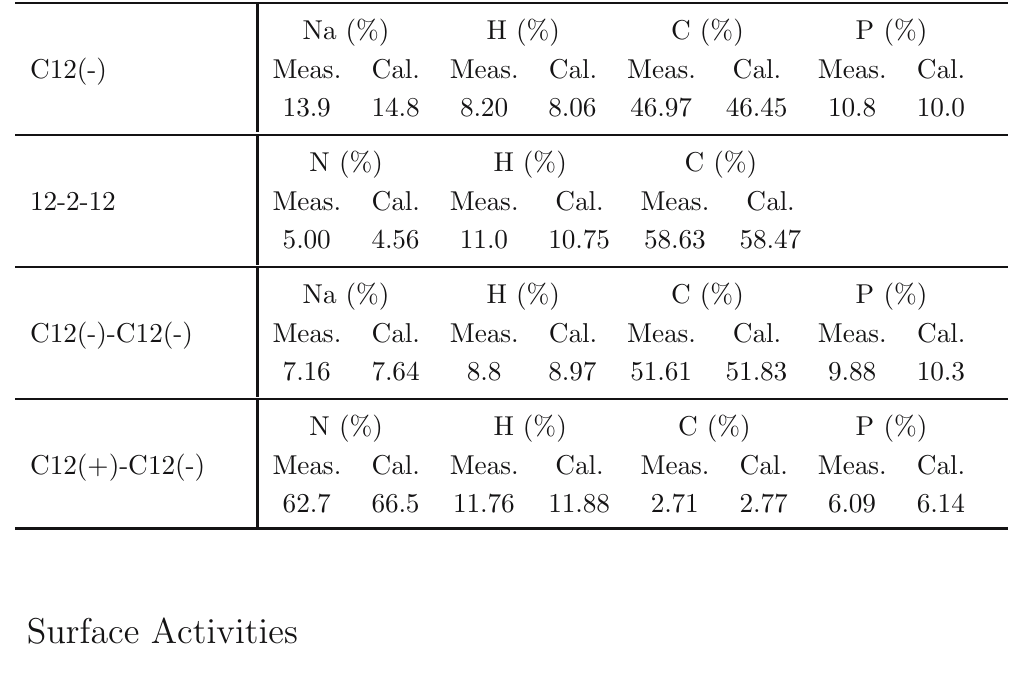
Table 2 Elemental Analysis Results of the Series of Surfactants.